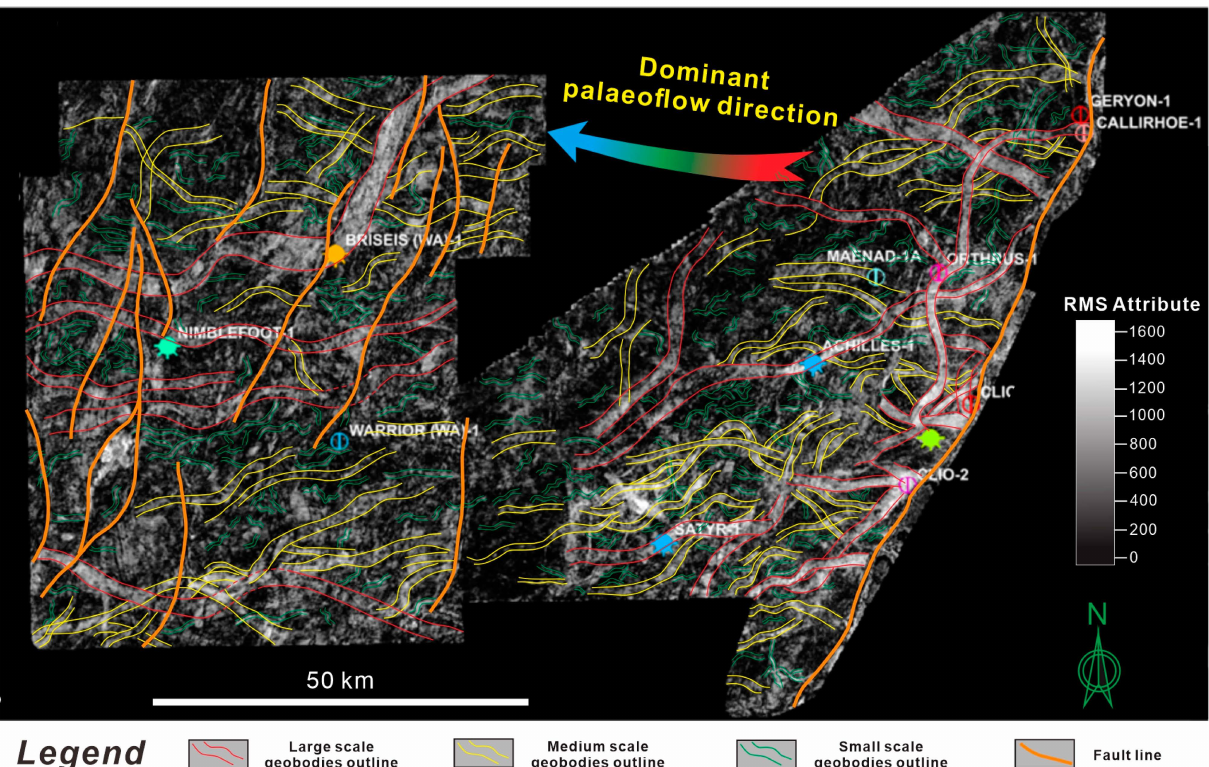
Figure 8. Root mean square (RMS) seismic amplitude attribute map of a 40 ms sculpt from the SQ2 of the Mungaroo Formation, showing the dominant paleoflow direction, characteristics, and dispersal pattern of the shallow-water braided delta distributary channels. See the location of this seismic attribute map in Figure